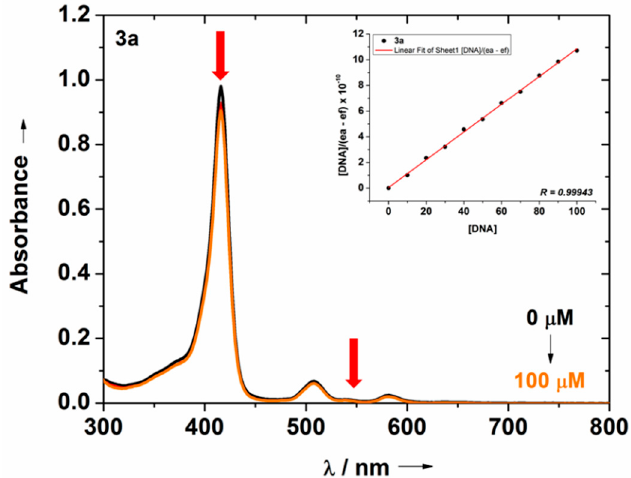
Figure 4. UV-vis titration absorption spectra of thioaryl-porphyrin 3a in a DMSO/Tris-HCl buffer (pH 7.4) mixture. The ct-DNA concentration ranged from 0 to 100 µM. The insert graph shows the plot of [DNA]/( ε a − ε f ) versus [DNA].